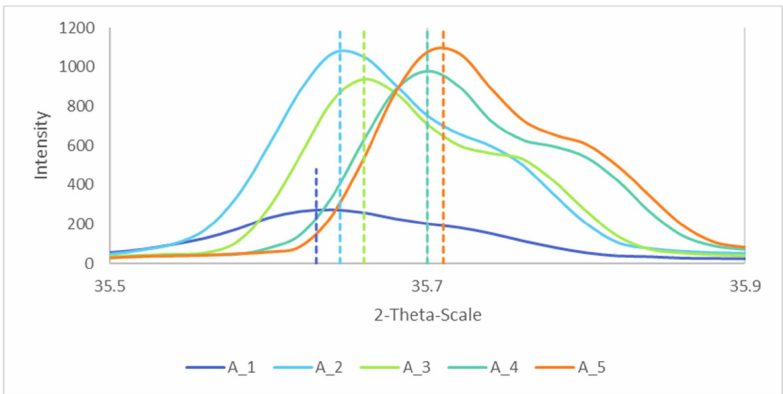
Figure 8. Bragg peaks of A_1, A_2, A_3, A_4 and A_5 for h = 3, k = 1 and l = 1, with their respective maxima as the dotted lines.